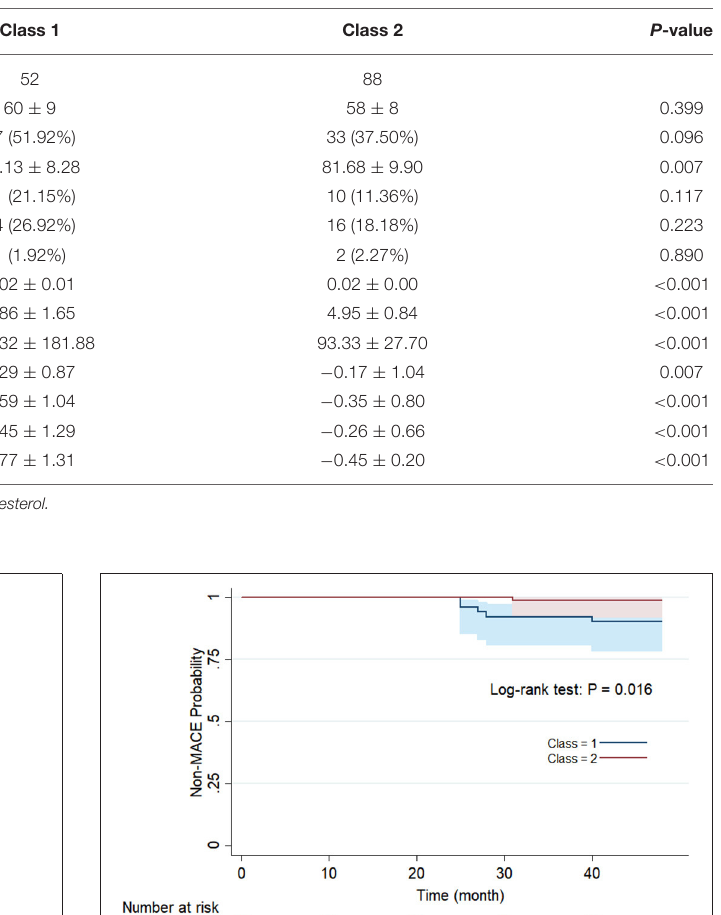
TABLE 2 | Baseline characteristics of the study population post classification.